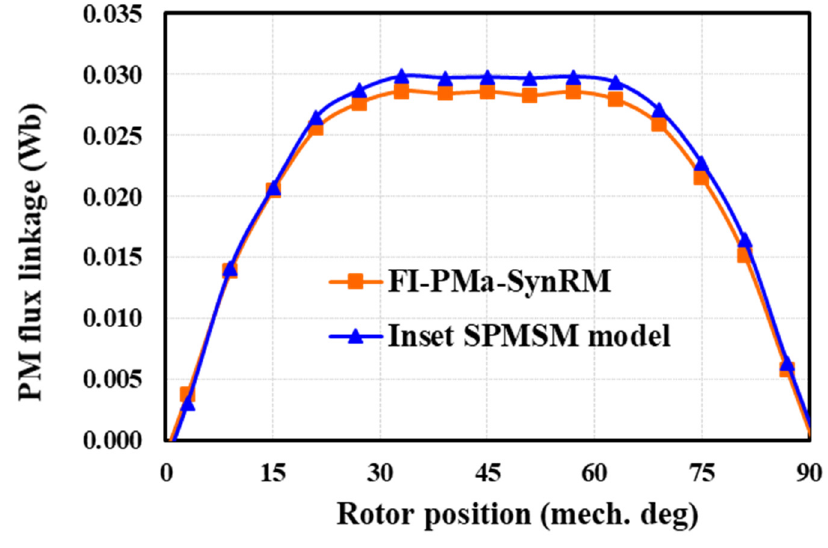
Figure 4. PM flux linkages.